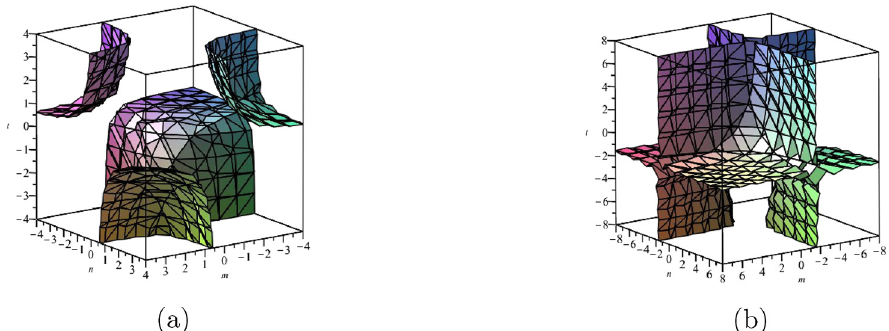
Figure 6: ( a ) The atom - bond connectivity index and ( b ) the geometric - arithmetic index.